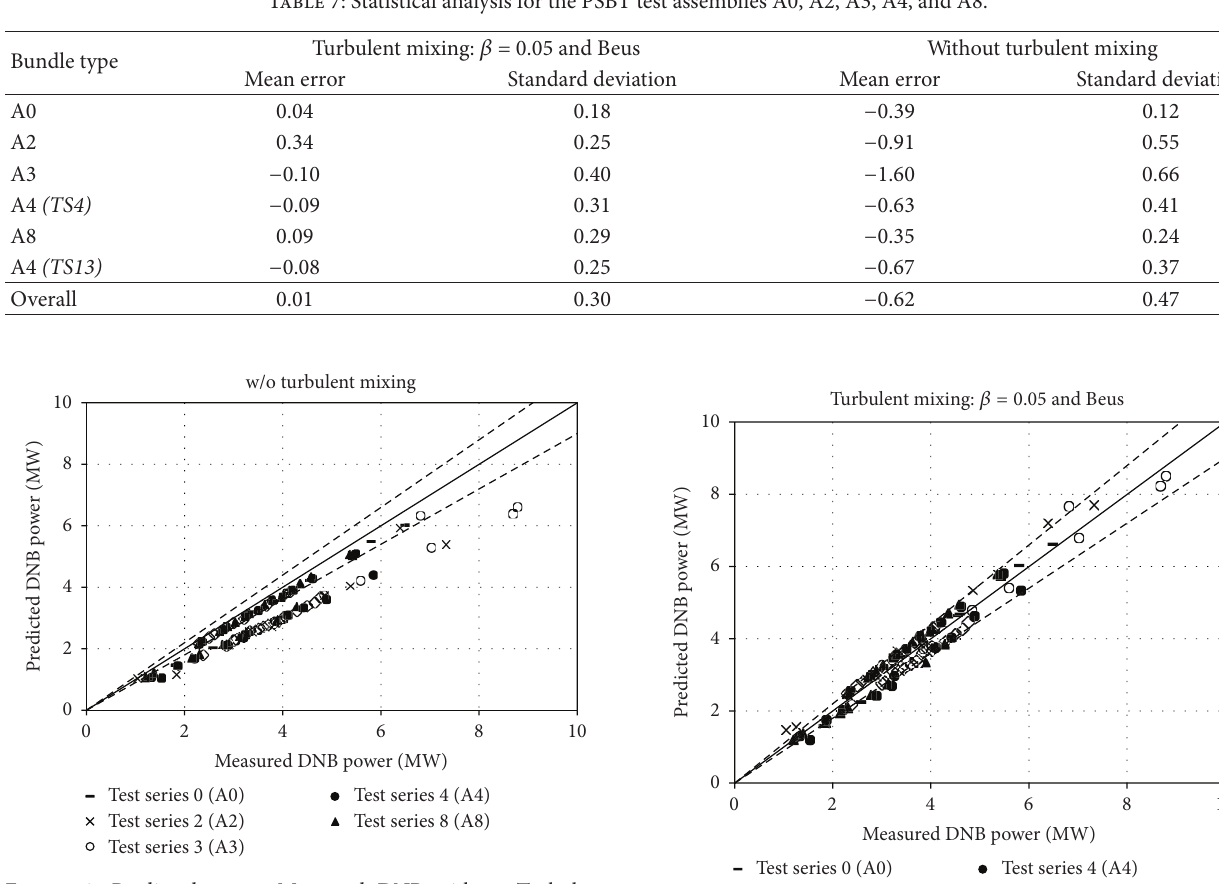
F 8: Predicted versus Measured DNB without Turbulent Mixing and Void Dri Modeling.